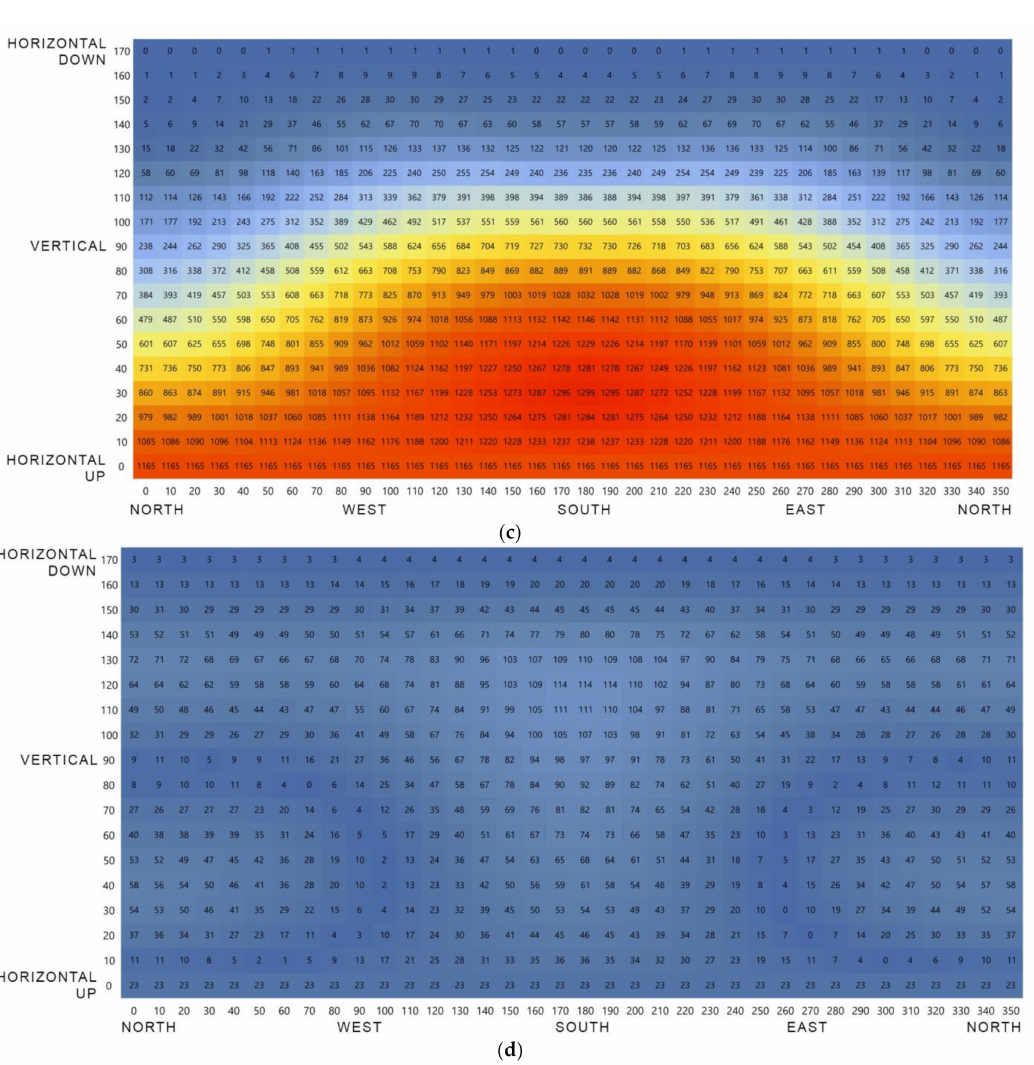
Figure 1. Look-up tables for annual irradiation [kWhm − 2 ] of every 10 ◦ spatial rotation of the plane. ( a ) Spatial rotation of the abstract plane every 10 ◦ . ( b ) Calculation by Ladybug. ( c ) calcu- lation using the Kittler and Mikler model. ( d ) Mean absolute error between these methodologies, MAE = 77.09 [kWhm − 2 ]; the values of the Kittler and Mikler model are